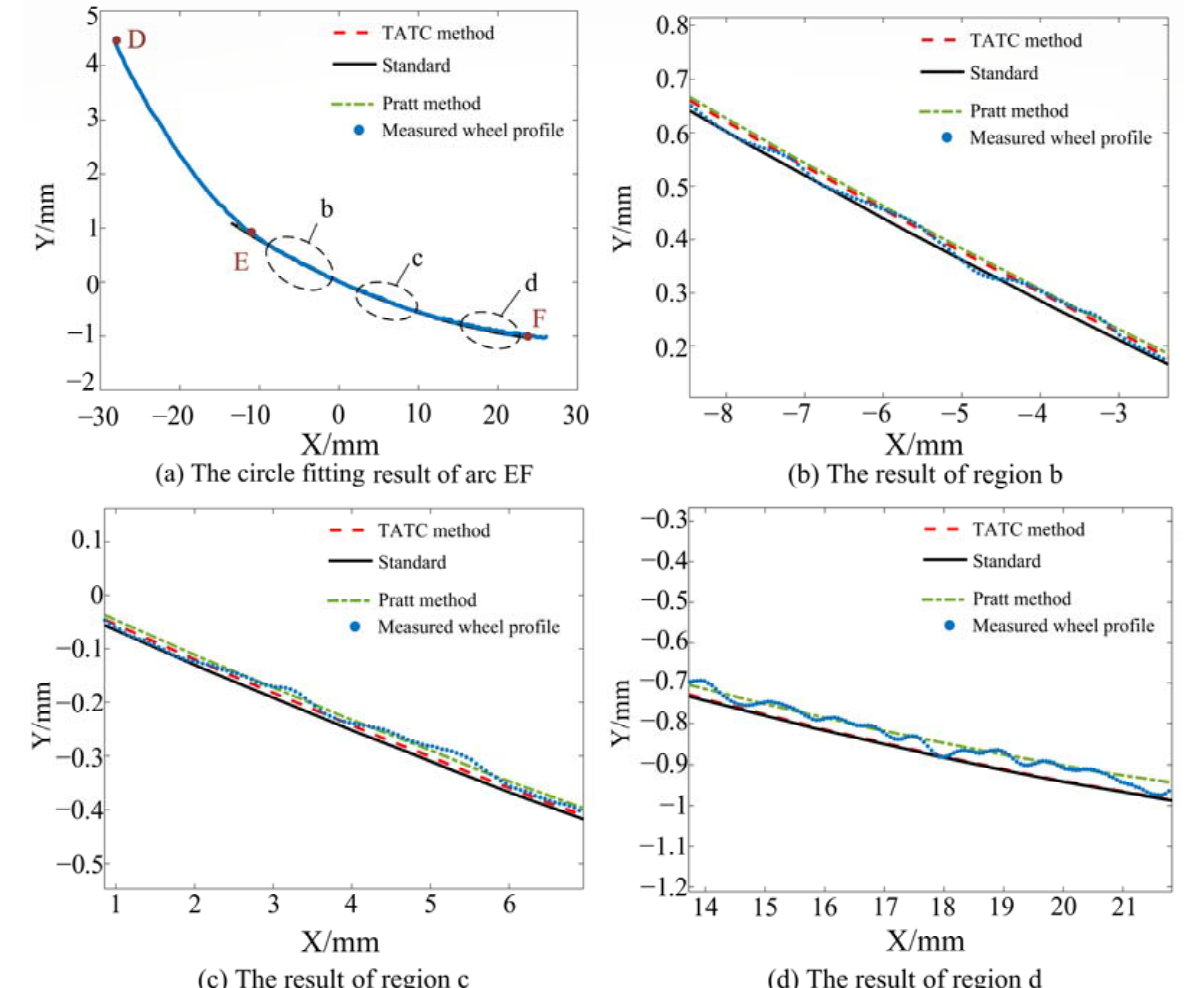
Figure 16. The result of fitting circle to arc EF of JM type.